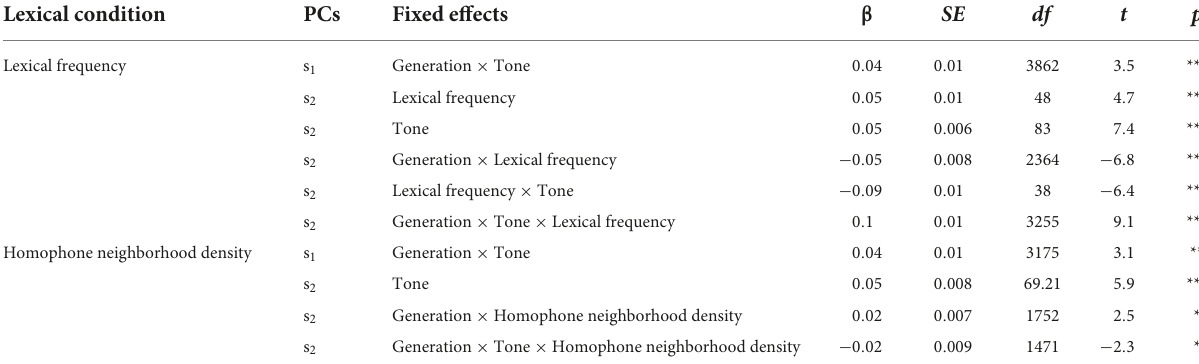
TABLE 2 Summary of linear mixed-effects modeling for F0 velocity profiles. Lexical condition PCs Fixed effects